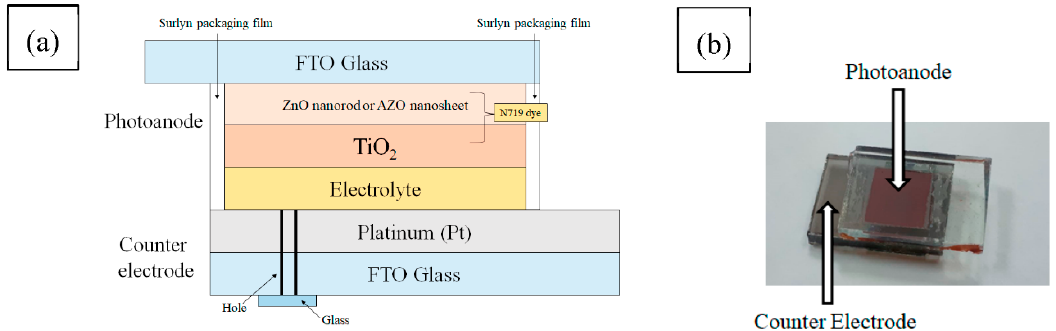
Figure 1. ( a ) Schematic diagram of the dye-sensitized solar cell (DSSC) structure. ( b ) Photograph of the DSSC packaging.